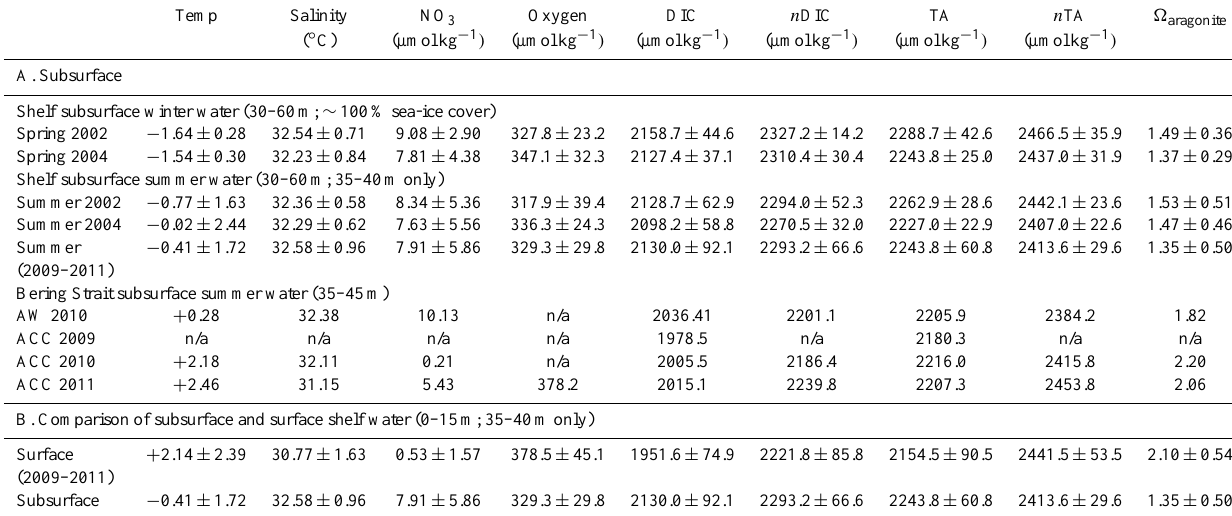
Table 2. Mean remnant “winter/early-spring” physical conditions, nutrient concentrations and seawater CO 2 -carbonate chemistry for 2002–2004 SBI data (May to early June) and 2009–2011 RUSALCA/ICESCAPE summer data. In B, the mean seawater CO 2 -carbonate chemistry of surface summertime and winter/early-spring water remnant of the shelf during summertime are compared. Temp Salinity NO 3 Oxygen DIC n DIC TA n TA (cid:127) aragonite ( ◦ C) (µmolkg − 1 ) (µmolkg − 1 ) (µmolkg − 1 ) (µmolkg − 1 ) (µmolkg − 1 ) (µmolkg − 1